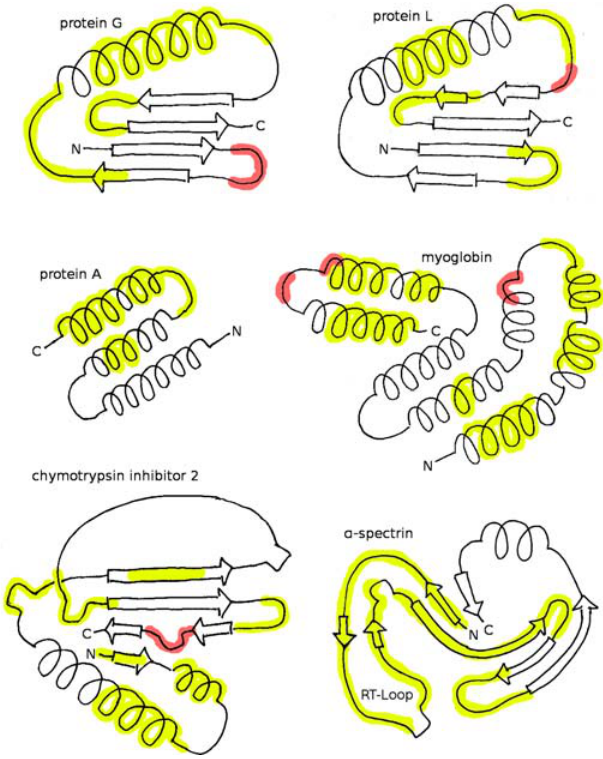
Figure 4. Distribution of Kinks in the Topology of Protein Structures a helices and 3 10 helices are drawn as coils, hydrogen-bonded b -turns are drawn as a notch, and b strands are drawn as arrows. Yellow indicates helical-turn [-aaa-] and red indicates reverse-turns [baab]. 11 of the 14 a helices contain a helical-turn. The turns of all seven b hairpins contain a peptide fragment that is structured. DOI: